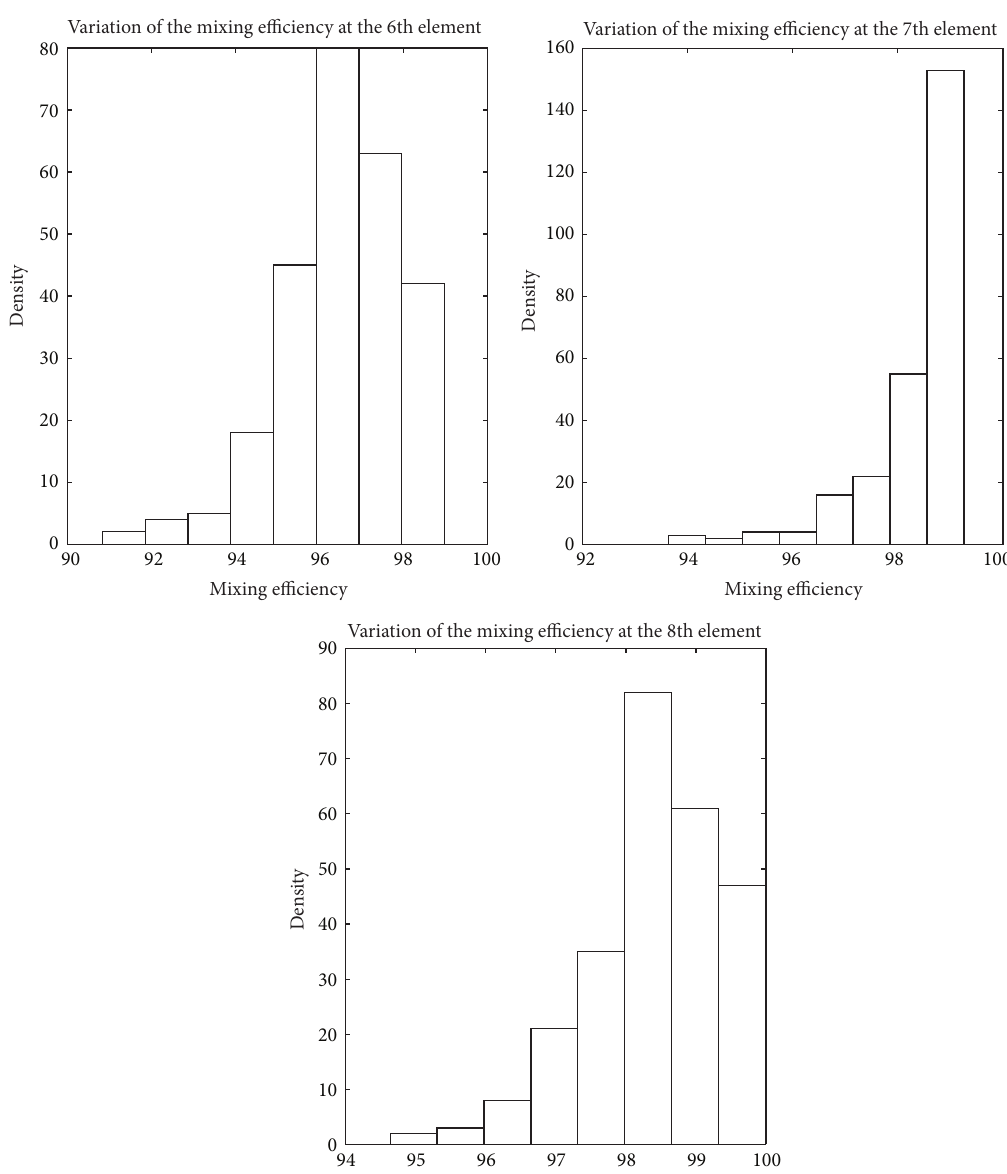
Figure 8: Histograms of the results of the Monte Carlo simulation of the tesla micromixer at the outlets of the 6th up to the 8th tesla elements.